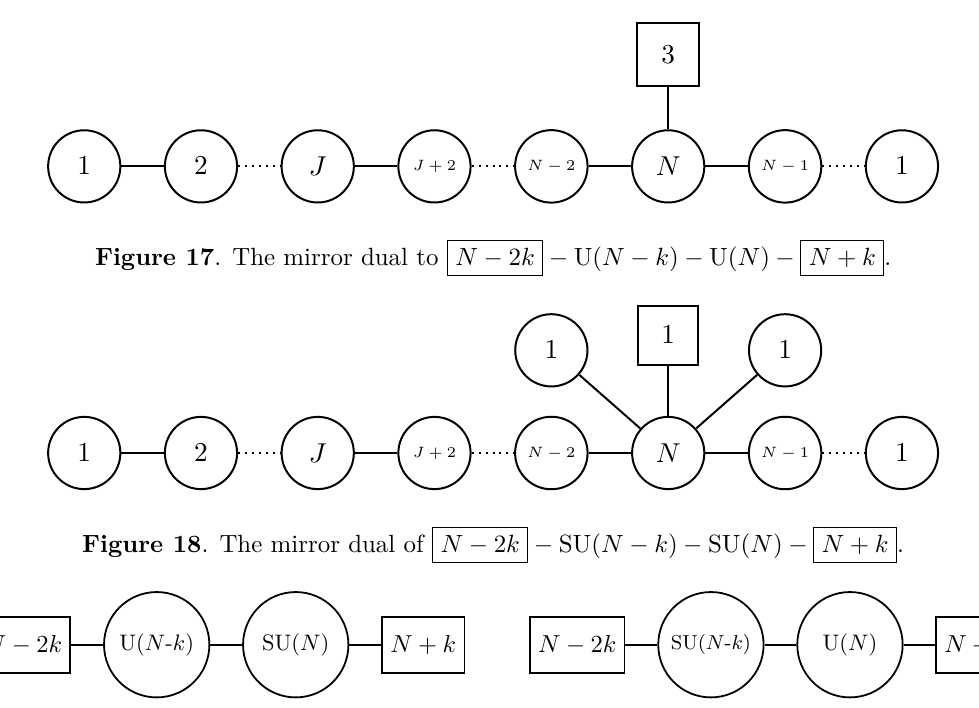
Figure 19 . The two linear quivers with a single balanced gauge